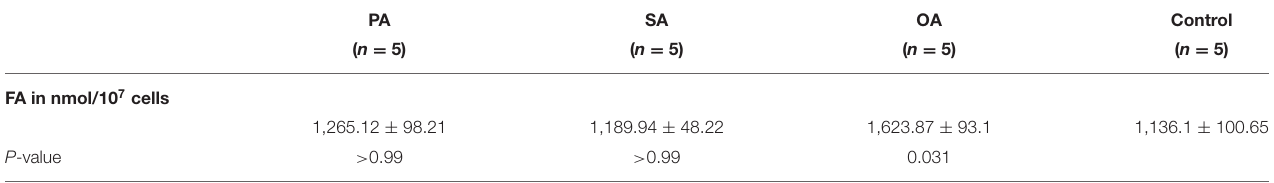
TABLE 2 | Total amount of fatty acids (FA) after supplementation with palmitic acid (PA), stearic acid (SA), or oleic acid (OA).